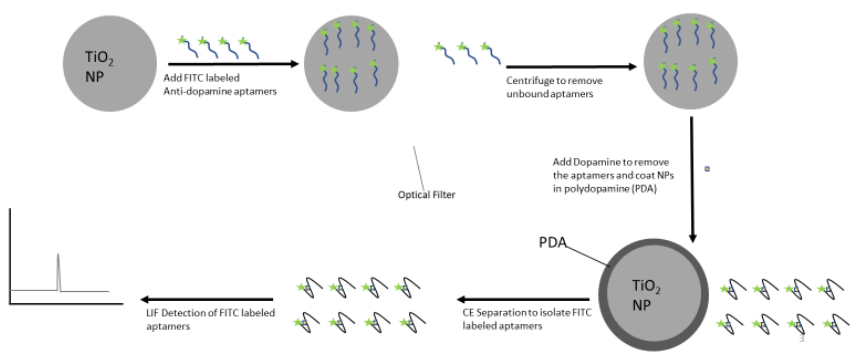
Figure 3. Detection method for titania nanoparticles (TiO 2 NPs) based on dopamine aptamer.